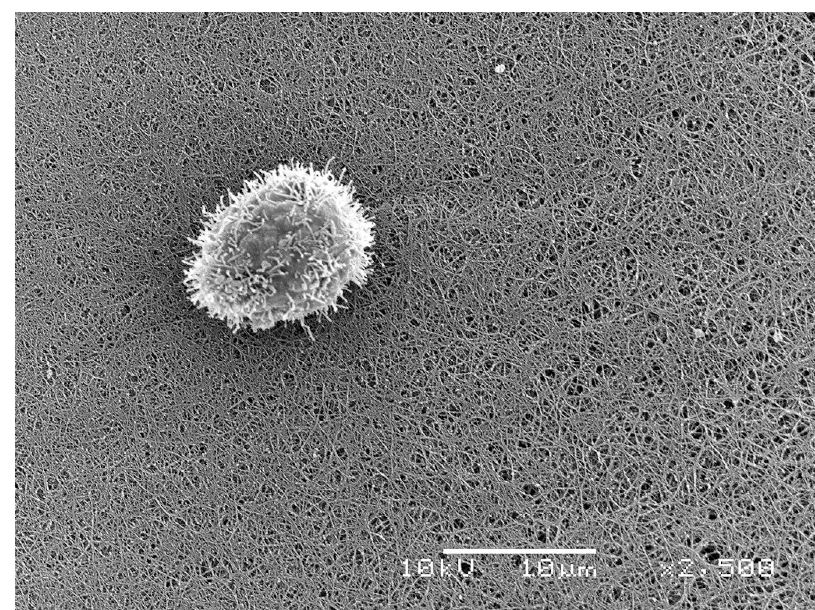
Figure 1. Scanning microscopy analysis of the heterologous fibrin sealant (HFS)